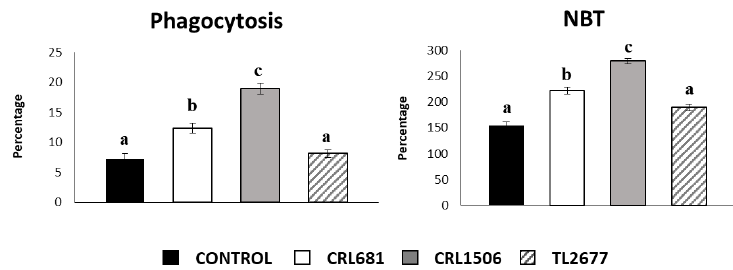
Figure 5. Effect of Lactiplantibacillus plantarum CRL681, CRL1506 or TL2677 on peritoneal macrophages activities. Mice were orally treated with L. plantarum CRL681, CRL1506 or TL2677 (10 8 cells/mouse per day for 5 consecutive days). Untreated mice were used as controls. One day after the last lactobacilli administration, phagocytic and bactericidal (oxidative burst) activities of peritoneal macrophages were determined. The results represent three independent experiments. Results are expressed as mean ± SD. Bold letters indicate significant differences when compared to the control group ( p < 0.05).